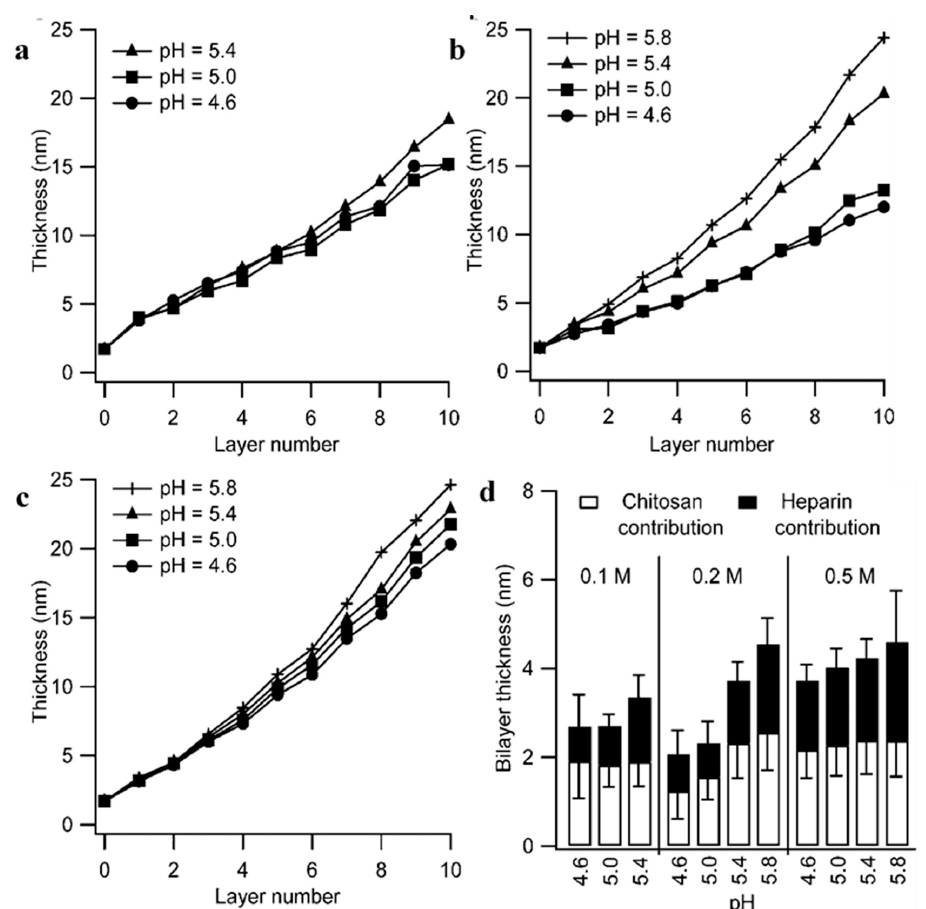
Figure 9. PEM thickness obtained from in situ Fourier transform-surface plasmon resonance (FT-SPR) data as a function of layer number and pH for 0.1 M buffer ( a ), 0.2 M buffer ( b ), and 0.5 M buffer ( c ). Odd numbered layers are CHI and even-numbered layers are HS. ( d ) Average incremental bilayer thickness of PEM at different buffer conditions as a function of pH. Figures taken from reference [71],